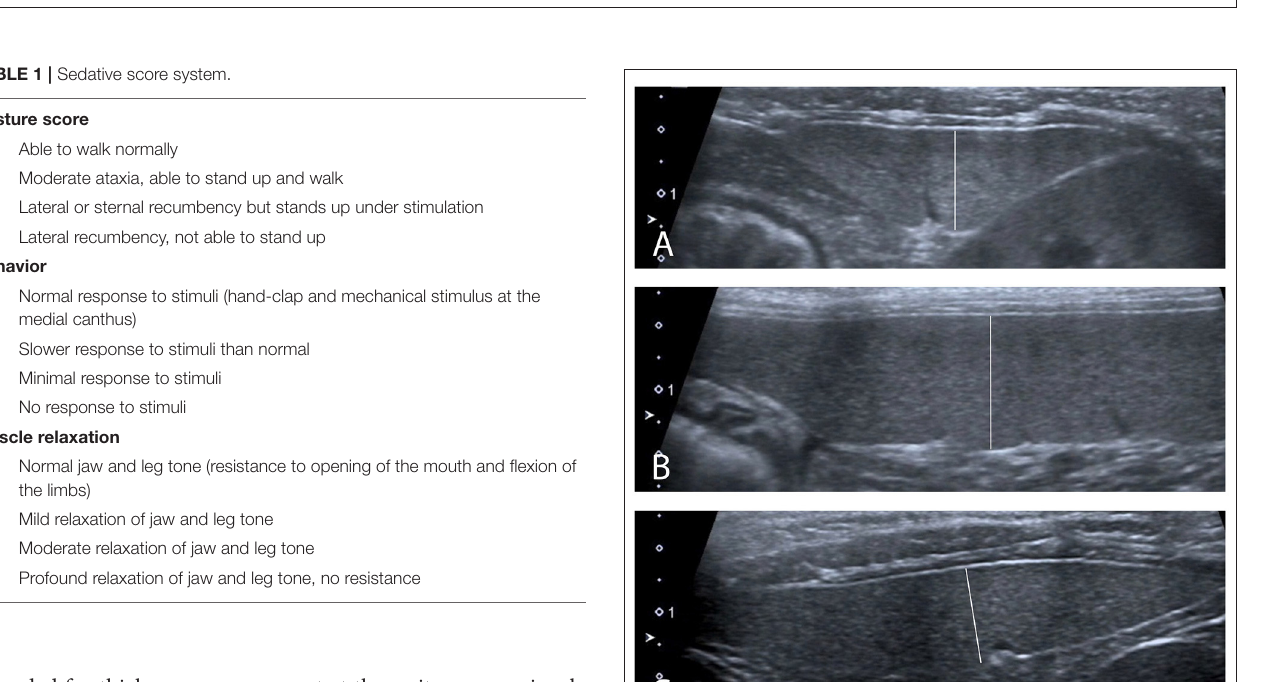
FIGURE 1 | Cross over design for sedatives administration according to groups and imaging tests.